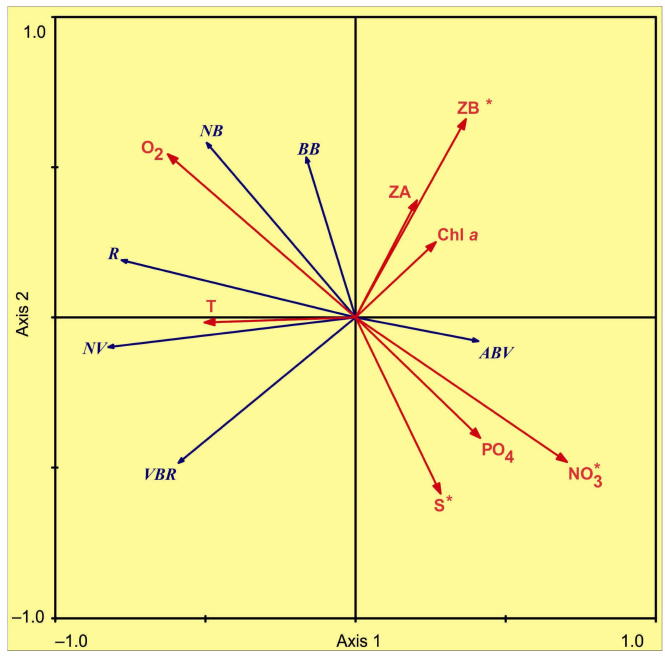
Figure 7. Redundancy analysis (RDA) on lg(x + 1)-transformed microbial abundance, indicating the ordination of microbial parameters and environmental variables in the northeastern Barents Sea, in